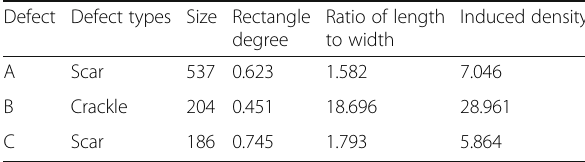
Table 2 Defect characteristic information Defect Defect types Size Rectangle degree